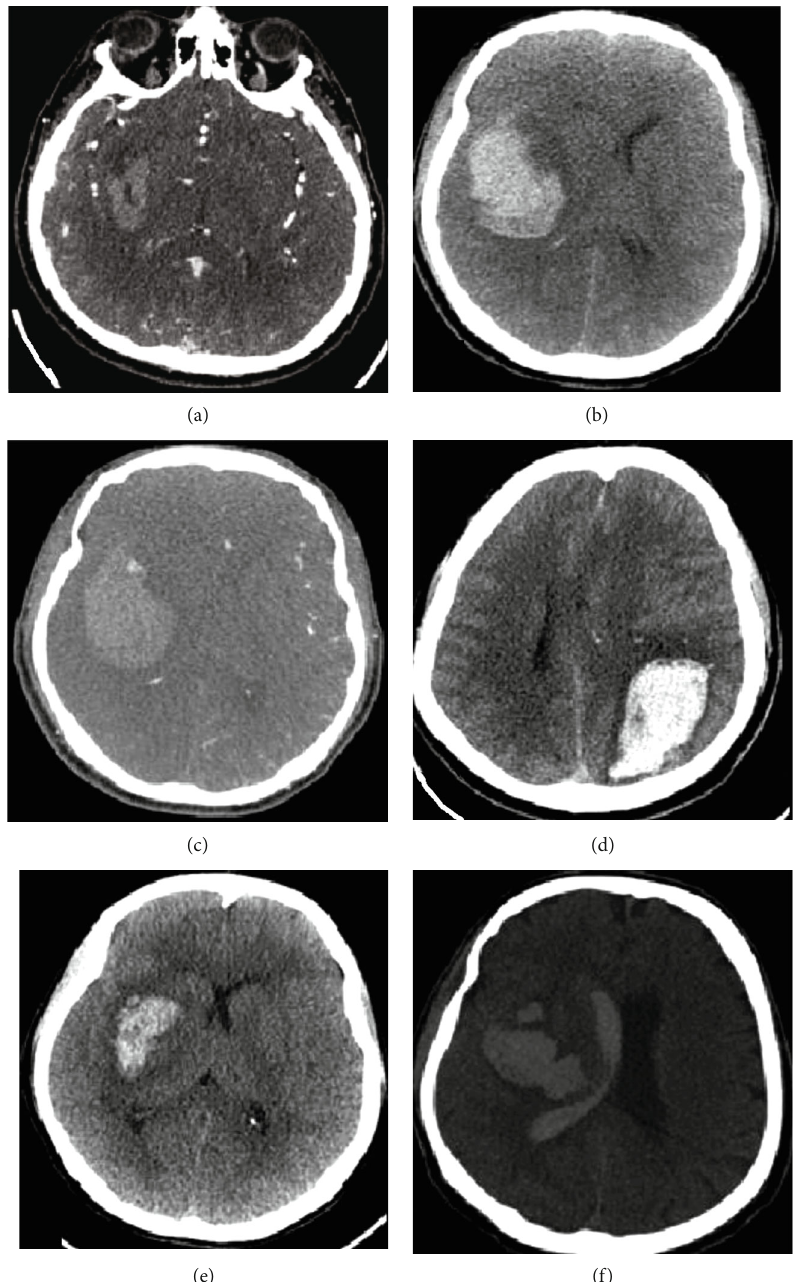
Figure 3: Signs of hematoma heterogeneity predicting expansion: (a) the “ black hole ” sign, (b) the “ blend ” sign, (c) the “ spot ” sign, (d) the “ island ” sign, (e) the “ satellite ” sign, and (f) a parenchymal hematoma extending into the lateral